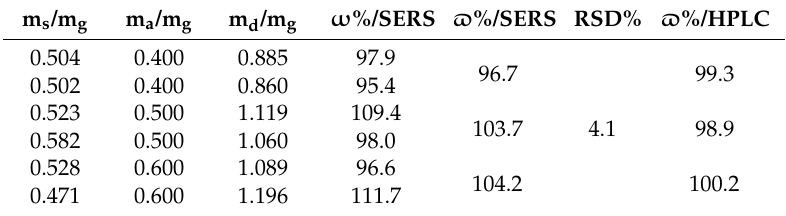
Table 1. Detection of positive samples with both SERS and HPLC method. m s : the detected mass of SH in capsules sample, m a : mass of SH added to capsules, m d : the detected mass of SH. ω % represents the recovery of detected SH compared to its real concentration. (cid:36) % is the mean value of ω % for three times of detection.